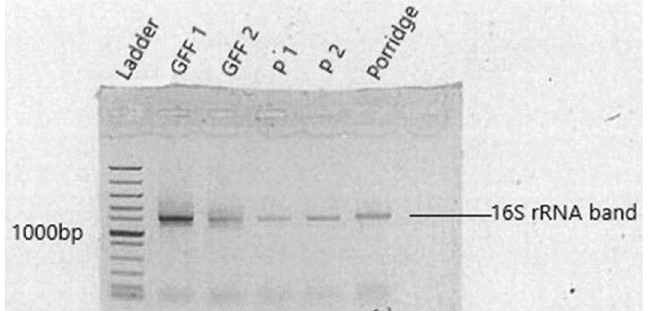
Figure 2. Agarose gel electrophoresis showing amplified 16S rRNA of the bacterial isolates. Lane ladder represents the 100 bp molecular ladder. The lanes (GFF1, GFF2, P1, P2 and Porridge) express the level of migration of genes on the agarose gel.